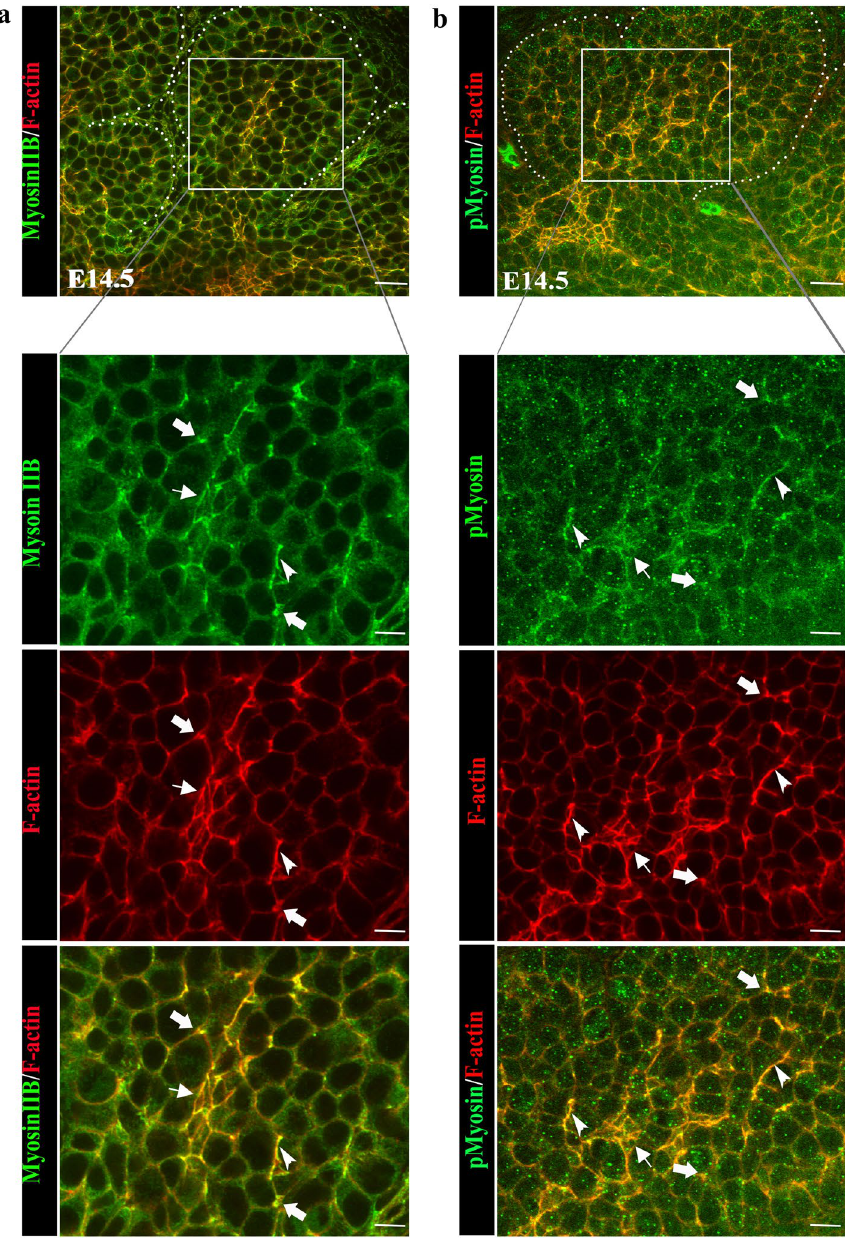
Figure 6. Myosin IIB participates in the mapping of the ductal tree. ( a ) Immunofluorescence staining for myosin IIB at E14.5 revealed a robust co-localization with F-actin in cells organizing into ductal structures (boxed area). Details of the region marked by a boxed area is shown in panels below. Myosin IIB (green) displayed a prominent punctate distribution at the apical domains of reorganizing ductal cells ( → ), with F-actin (red) demarcating newly forming ductal paths. ( b ) Active myosin IIB, phospho-myosin IIB, was co-localized with F-actin to the sites of asymmetry in the extending proximal ductal regions (boxed area). Region marked by the square is shown in detail in a panel below. Phospho-myosin IIB (green) was broadly distributed at the apical domains of reorganizing ductal cells along the F-actin-marked ductal paths ( → ). Size bars, 20 μm. Images are representative of 5 independent experiments (n =